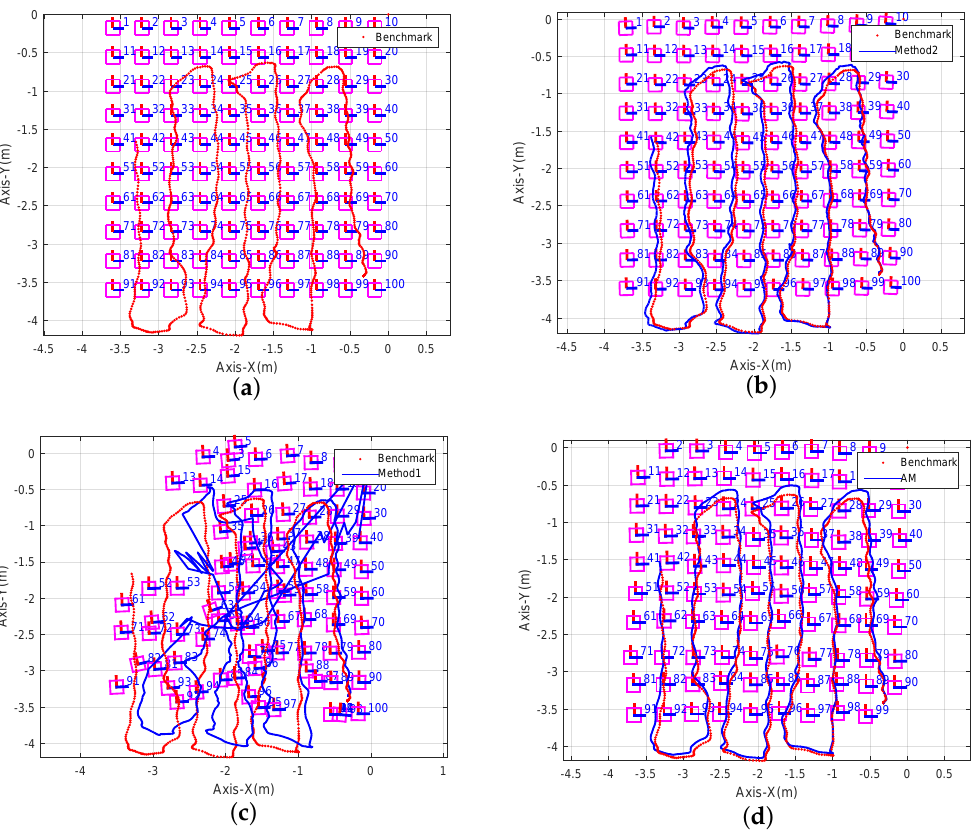
Figure 6. Result of Comparison Experiments. ( a ) Manual Calibrated Map; ( b ) Map of Method 2; ( c ) Map of Method 1; ( d ) Map of the Proposed System.